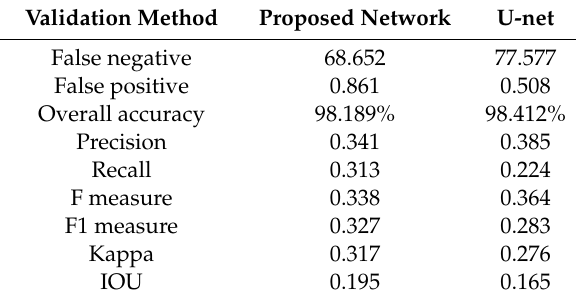
Table 8. Accuracy of the model in the Xiamen